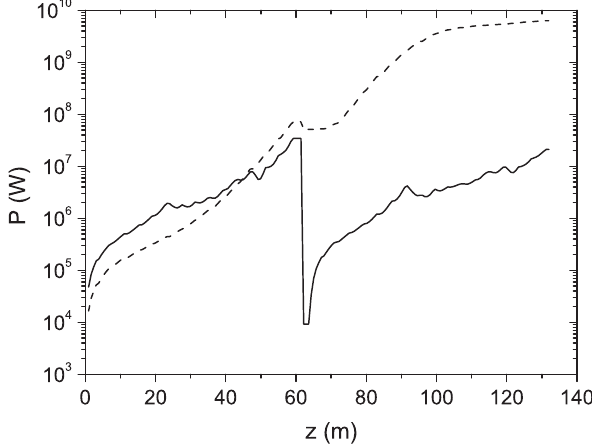
FIG. 7. Averaged peak power for the fundamental harmonic (solid) and the third harmonic (dash) versus geometrical length of the LCLS undulator (including breaks). The wavelength of the third harmonic is 0.5 A˚ (photon energy 25 keV). Beam and undulator parameters are in the text. The fundamental is dis- rupted with the help of the spectral filter (see the text) and of the phase shifters. The phase shifts are 4 (cid:1)= 3 after segments 1–5 and 17–22, and 2 (cid:1)= 3 after segments 6–10 and 23–28. Simulations were performed with the code FAST